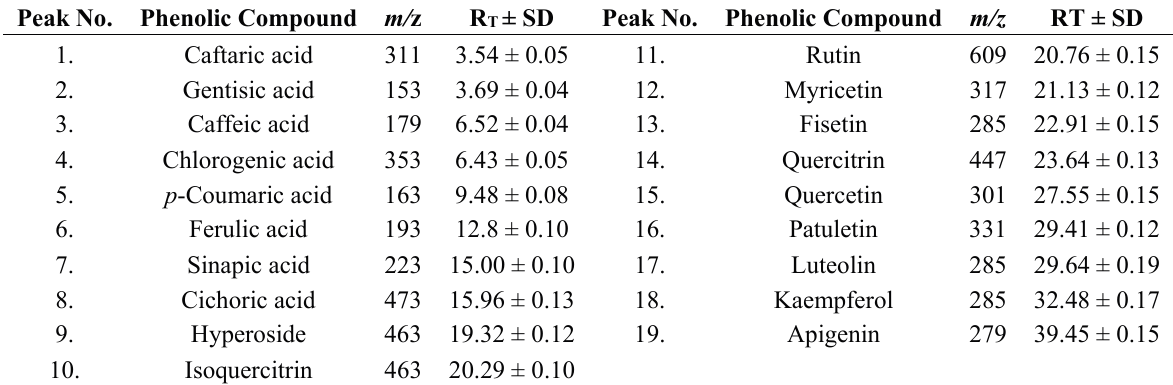
Table 7. Retention times (R T ) of polyphenolic compounds